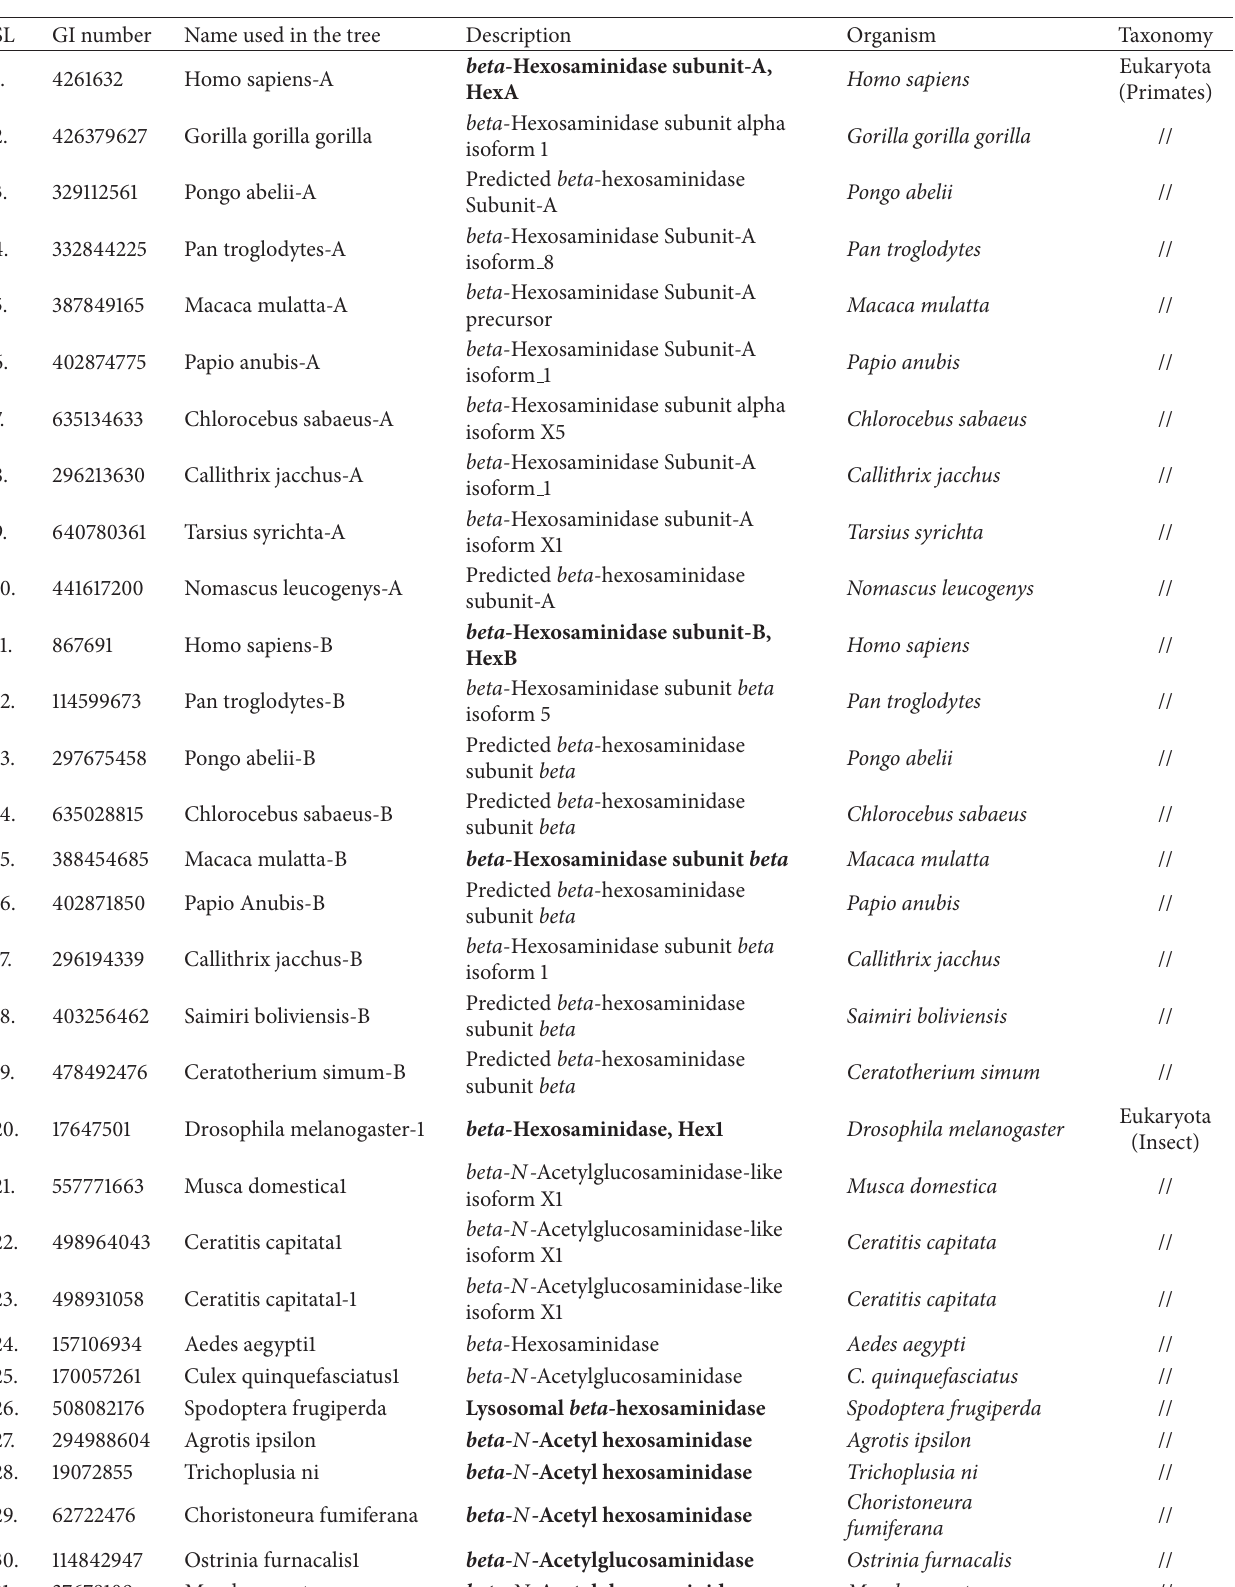
Table 1: Proteins sequences used for construction of phylogenetic studies.